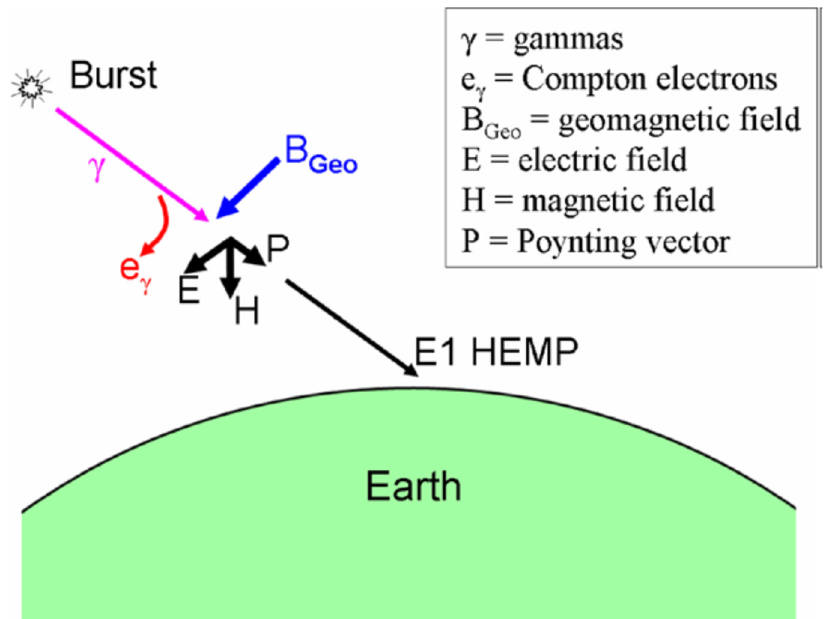
Figure 10. General basis of the EMP generation process. Gammas from the nuclear burst interact with the upper atmosphere generating Compton electrons, which are turned in the Earth’s geomagnetic field, and produce a transverse current that radiates an EM pulse towards the Earth [301].